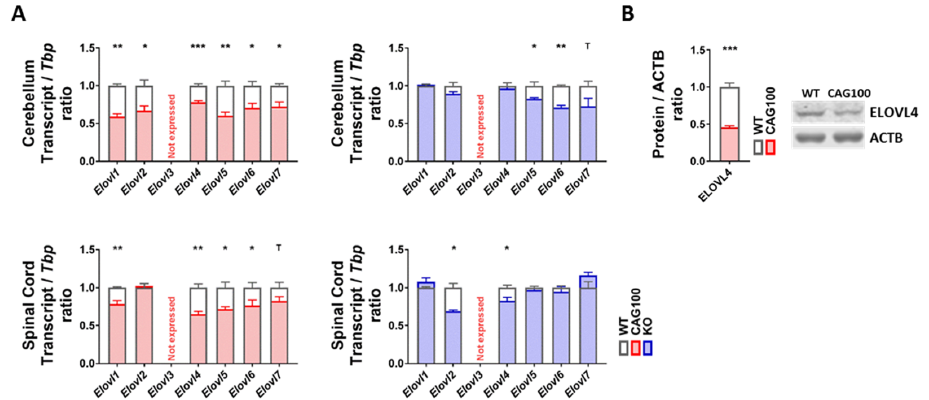
Figure 6. Strong and consistent downregulations were observed for elongase enzymes in the cerebellum and spinal cord of Atxn2 -CAG100-KIN and Atxn2 -KO mice which would affect synthesis of very long-chain fatty acids. ( A ) Transcript expression levels for different elongase isoforms. ( B ) Protein levels of ELOVL4 were documented in >12 month old Atxn2 -CAG100-KIN cerebellum tissue. Student’s t -tests were used with Welch’s correction; T p < 0.1, * p < 0.05, ** p < 0.01, *** p < 0.001.